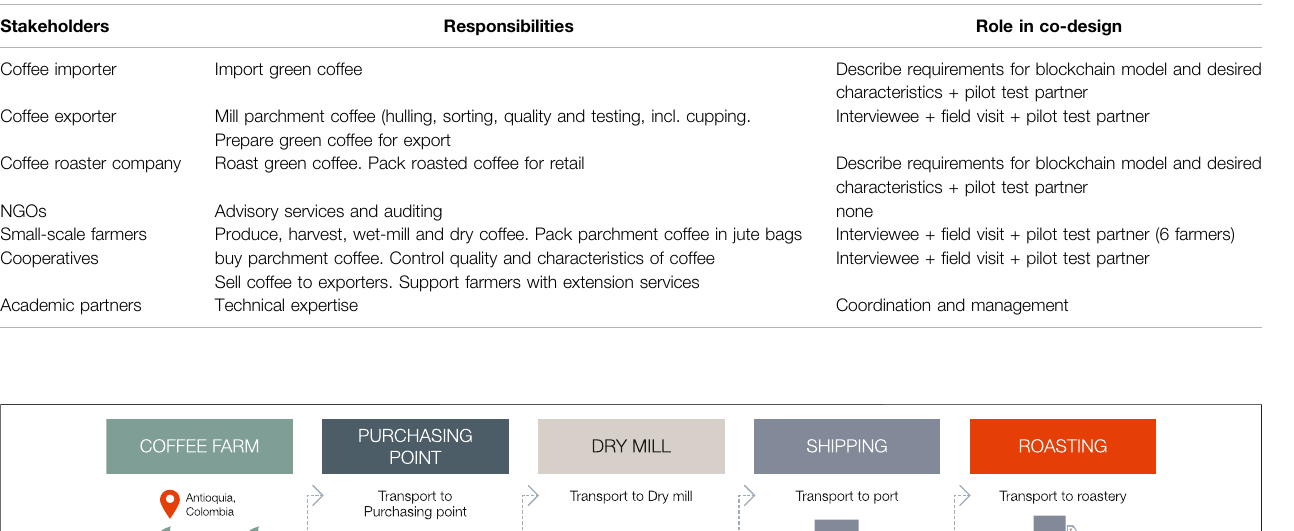
TABLE 1 | Stakeholders and responsibilities.